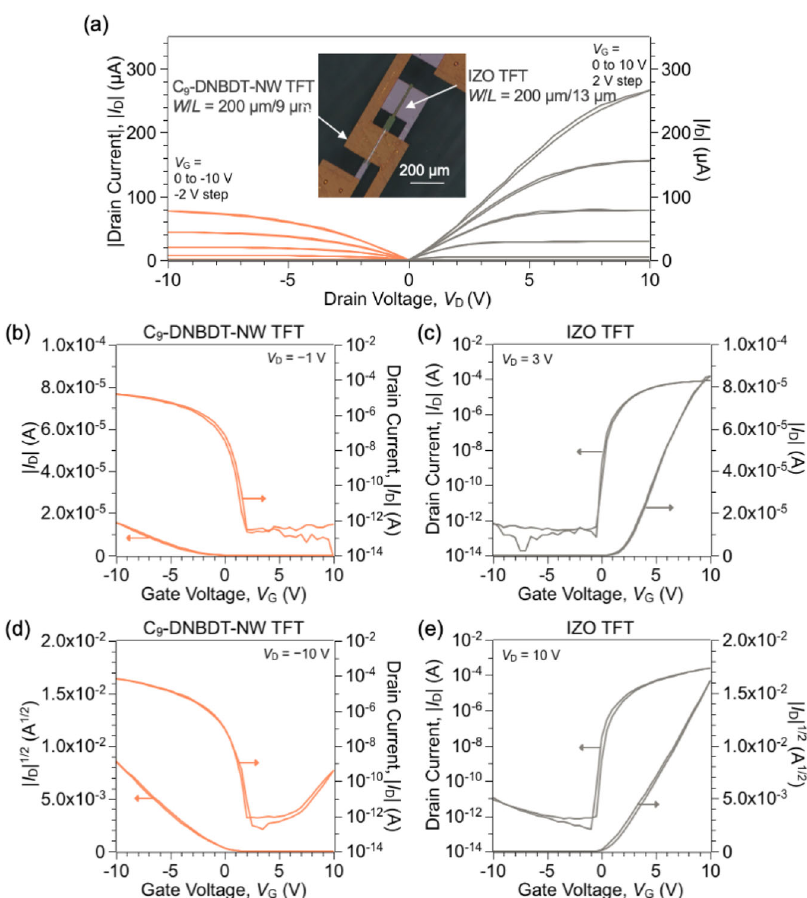
Fig. 2 Electrical performance of C 9 -DNBDT-NW- and IZO-based TFTs. a Output performance. The inset shows a micrograph of a complementary inverter with channel width ( W )/length ( L ) = 200 μ m/9 μ m for the C 9 -DNBDT-NW p-channel and 200 µ m/13 µ m for the IZO n-channel. b – e Transfer characteristics in the linear region and the saturation region. V D drain